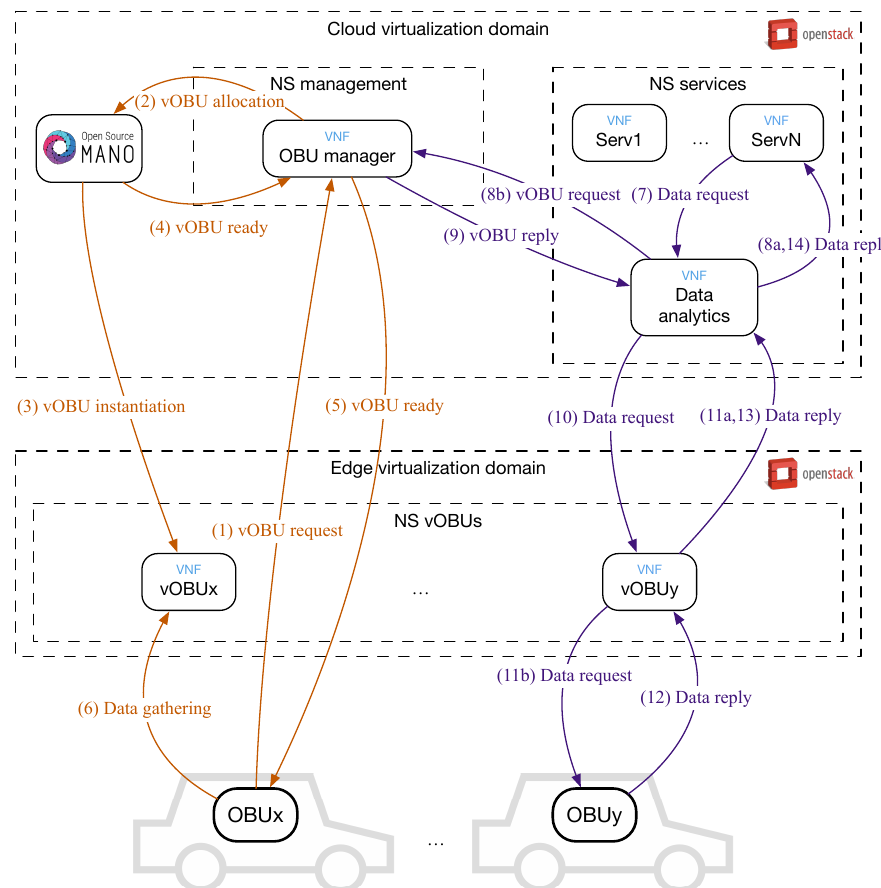
Figure 2. Operation of the system for virtual OBU (vOBU) bootstrapping ( left ) and data gathering ( right